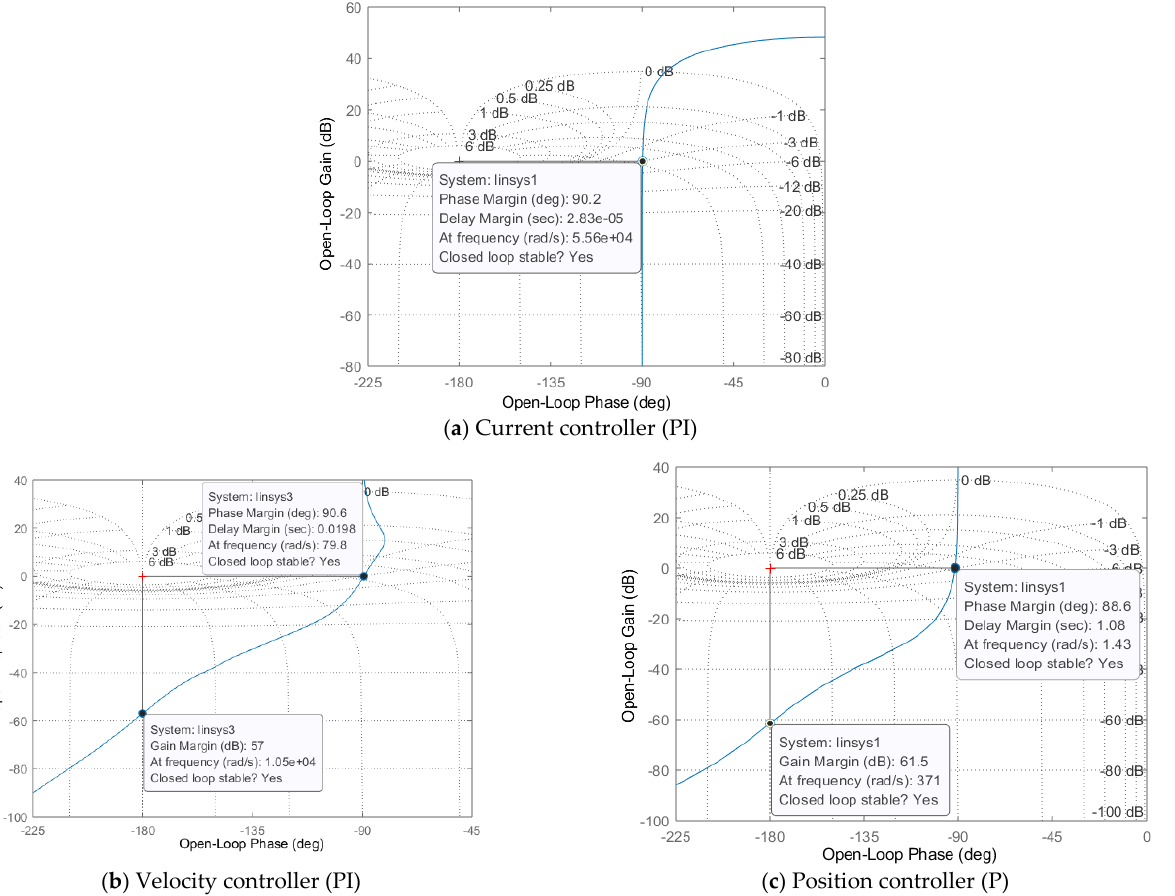
Figure 9. Nichols plot for the designed controllers ( a – c ).